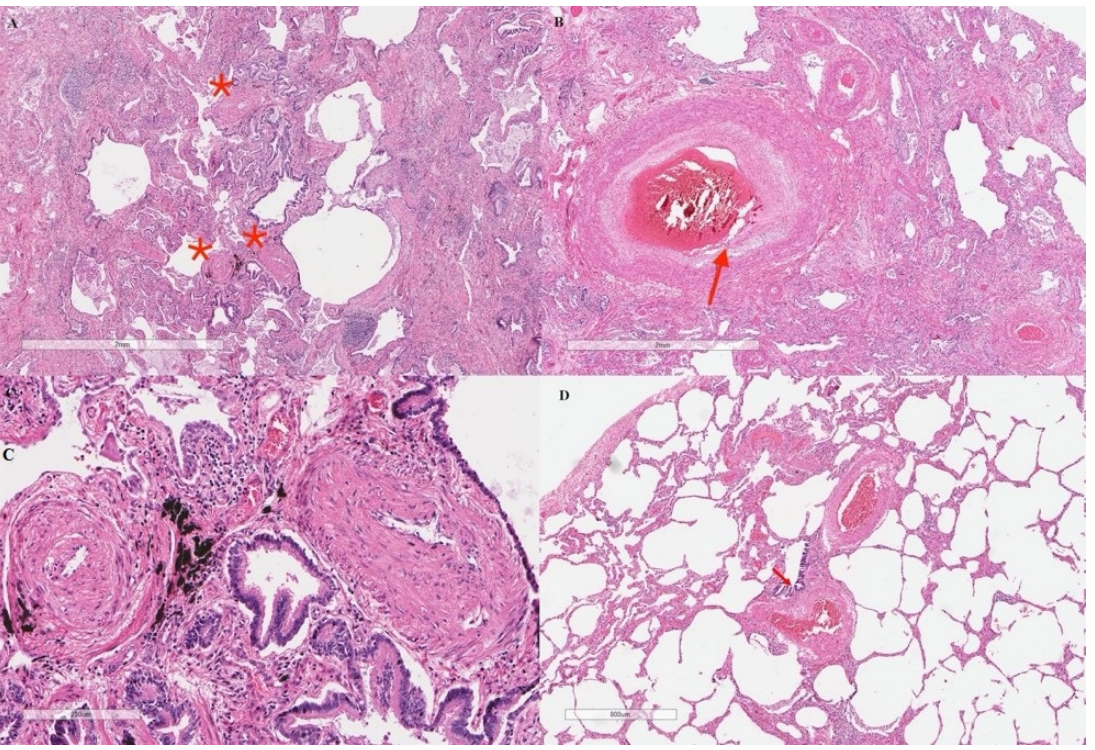
Figure 3. Histologic examination of the explanted lungs. Typical usual interstitial pneumonia pattern (UIP) underlying autoimmune disease with peribronchial metaplasia, interstitial fibrosis, nodular lymphocytic infiltration, and micro-honeycombing. Vascular remodelling throughout the lung parenchyma (stars on vessels) ( A ), haematoxylin and eosin stain (×20). Large/mid-sized arteries with diffuse aspects of medio-intimal hyperplasia ( B ), haematoxylin and eosin stain (×20). Small vessels showing medial hypertrophy and intimal fibrosis, leading to lumen narrowing ( C ), haematoxylin and eosin stain (×100). Vascular changes (arrow) were found in more preserved areas as well ( D ), haematoxylin and eosin stain (×20).